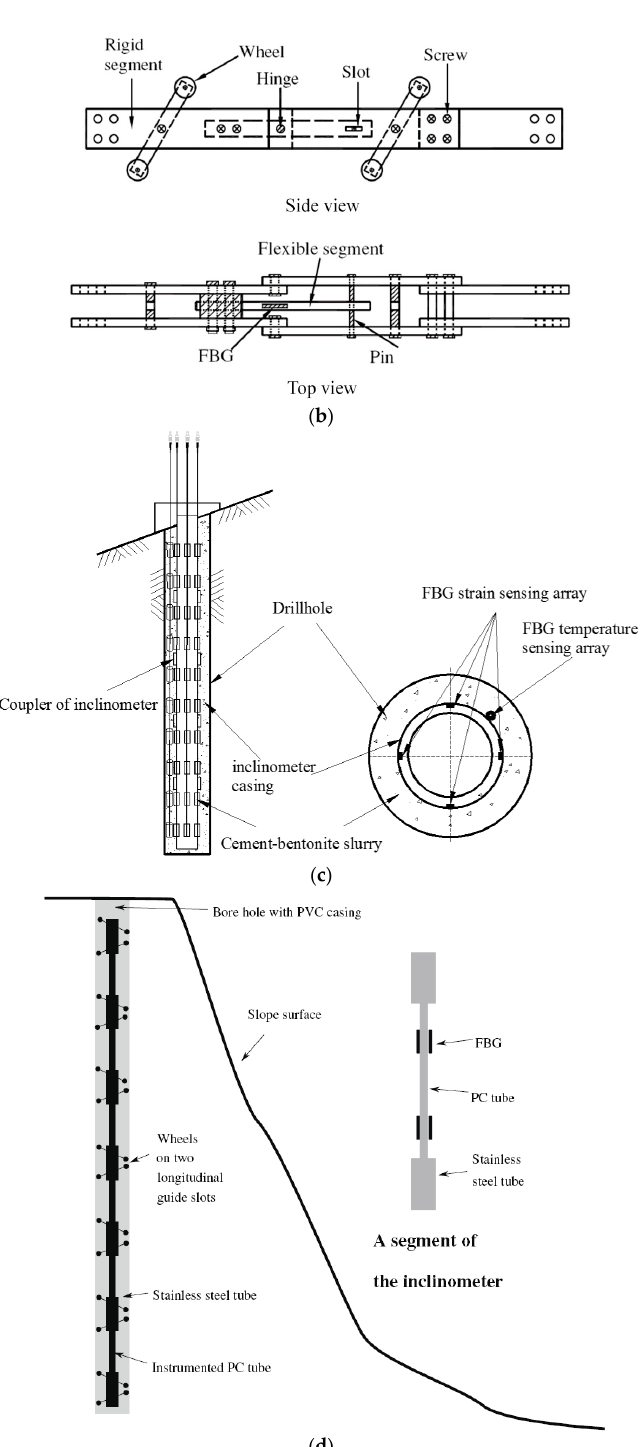
Figure 4. Schematic illustration of typical structures of FBG-based inclinometers. ( a ) FBG borehole inclinometer [47]; ( b ) FBG segmented deflectometer [16]; ( c ) FBG in-place inclinometer [15]; ( d ) New-generation FBG in-place inclinometer [45].